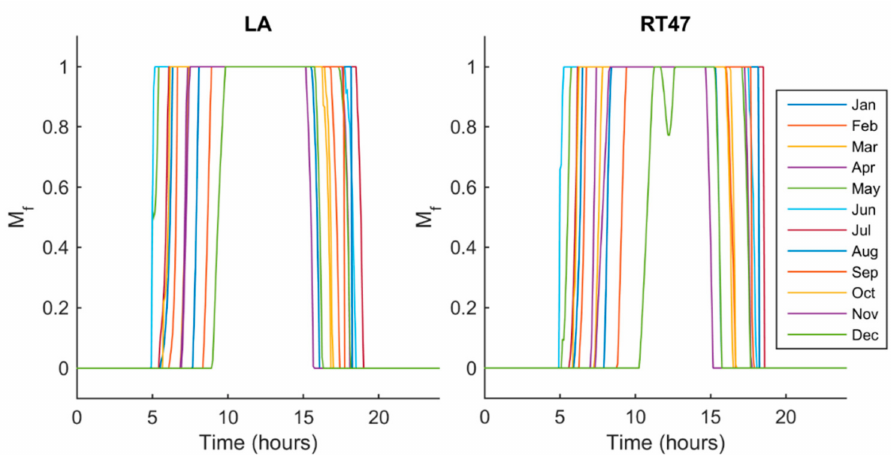
Figure 9. Melt fraction of LA and RT47 for all months of a year.